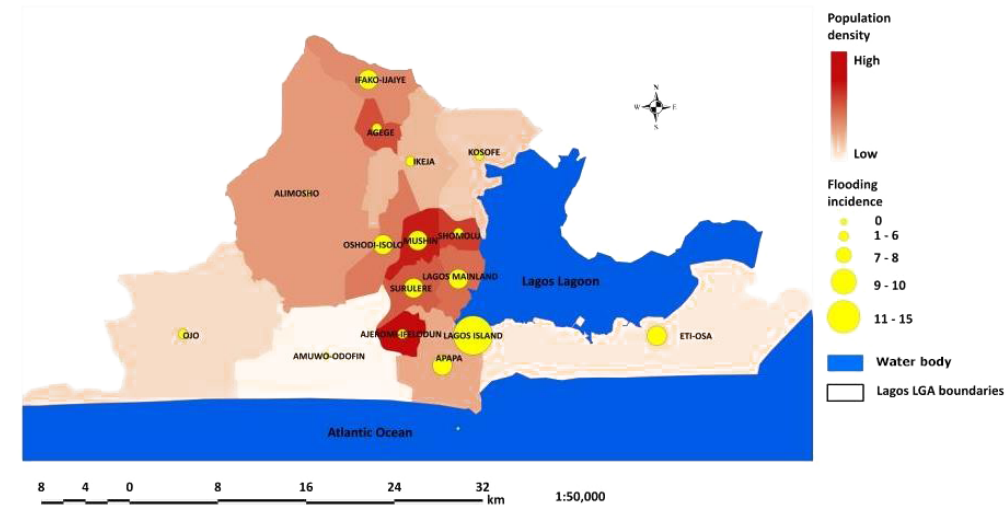
Figure 3. Flood risk levels in the Lagos area qualitatively determined by coupling population density with list of flooding events and